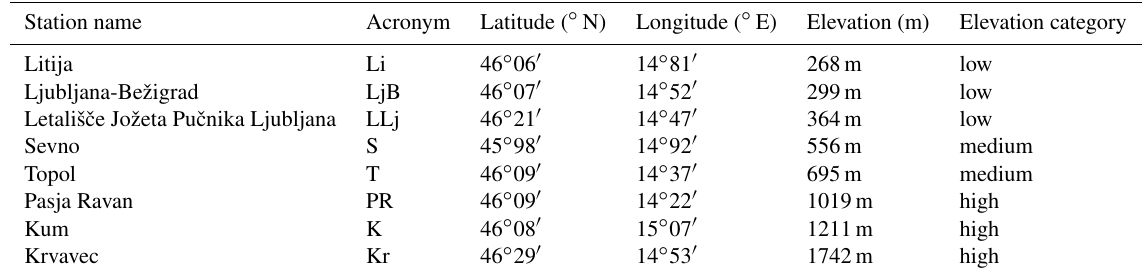
Figure 1. (a) Location of Slovenia within Europe, (b) topographic map of Slovenia with the location of Ljubljana indicated, and (c) to- pographic map of the Ljubljana basin, with the locations of automatic weather stations indicated. Basemap source: © https://www. openstreetmap.org/copyright, last access: 11 August 2019. Table 1. Ground-based automatic weather station name, abbreviation, position, elevation, and elevation